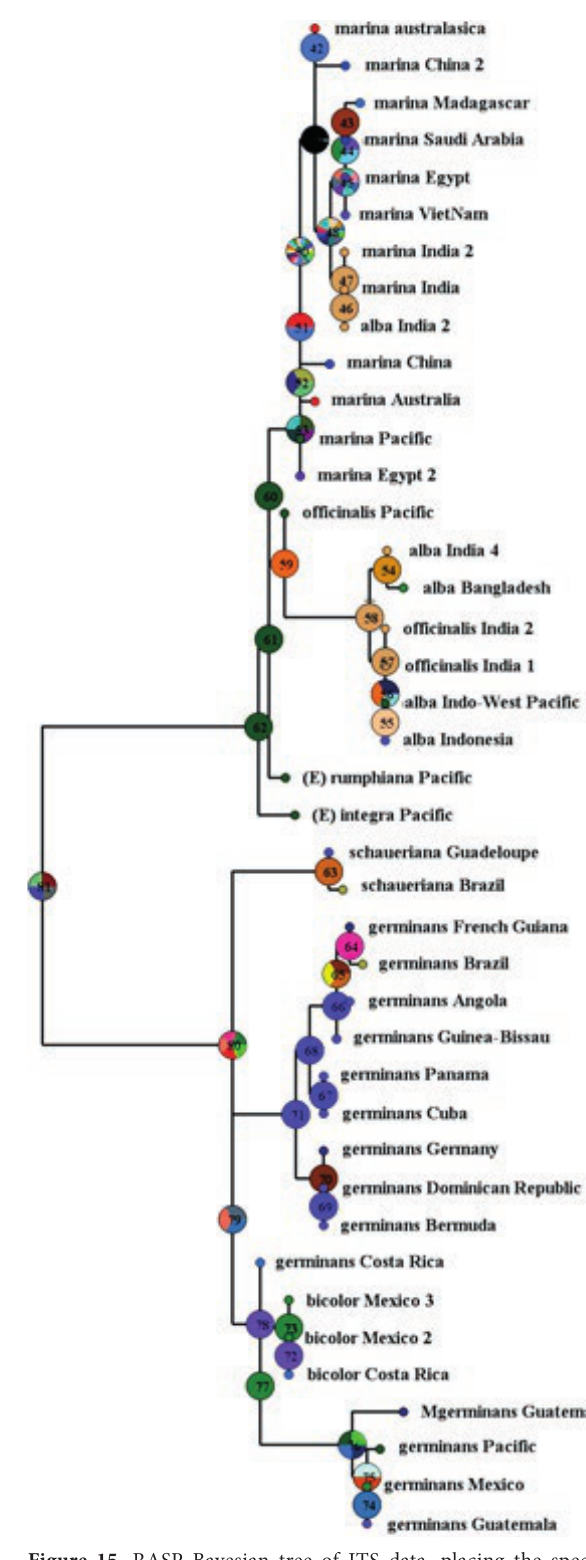
Figure 15. RASP Bayesian tree of ITS data, placing the species studied in two major